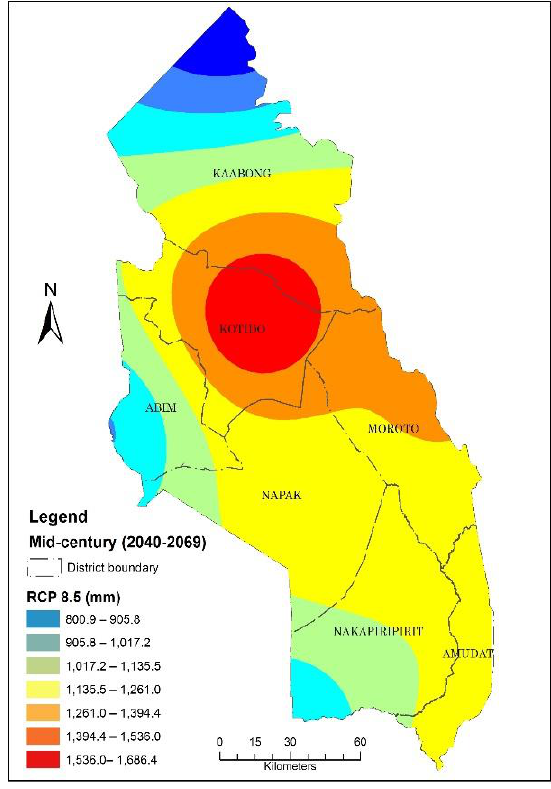
Figure 6. Rainfall distribution under RCP8.5 mid-century.